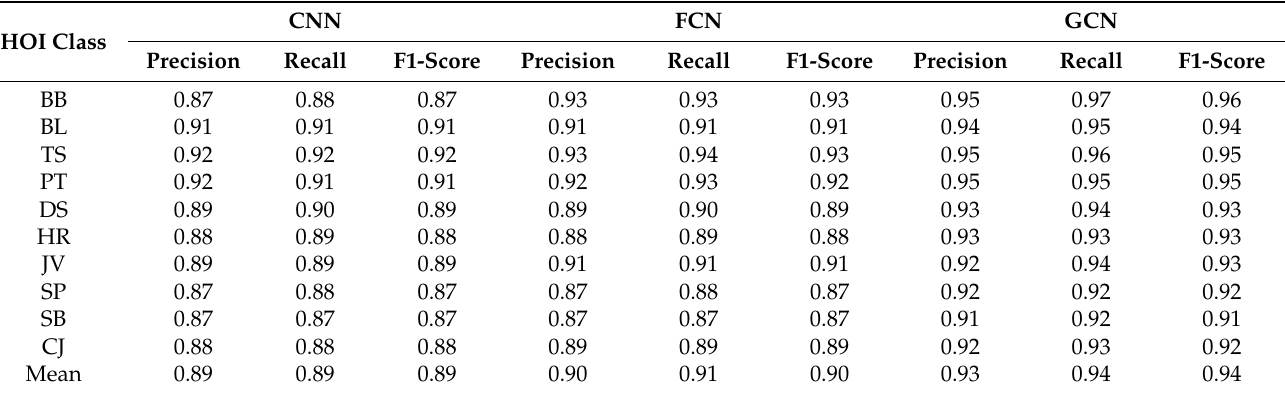
Table 6. Comparison of GCN with CNN and FCN classifiers on Olympic Sports dataset in terms of precision, recall and